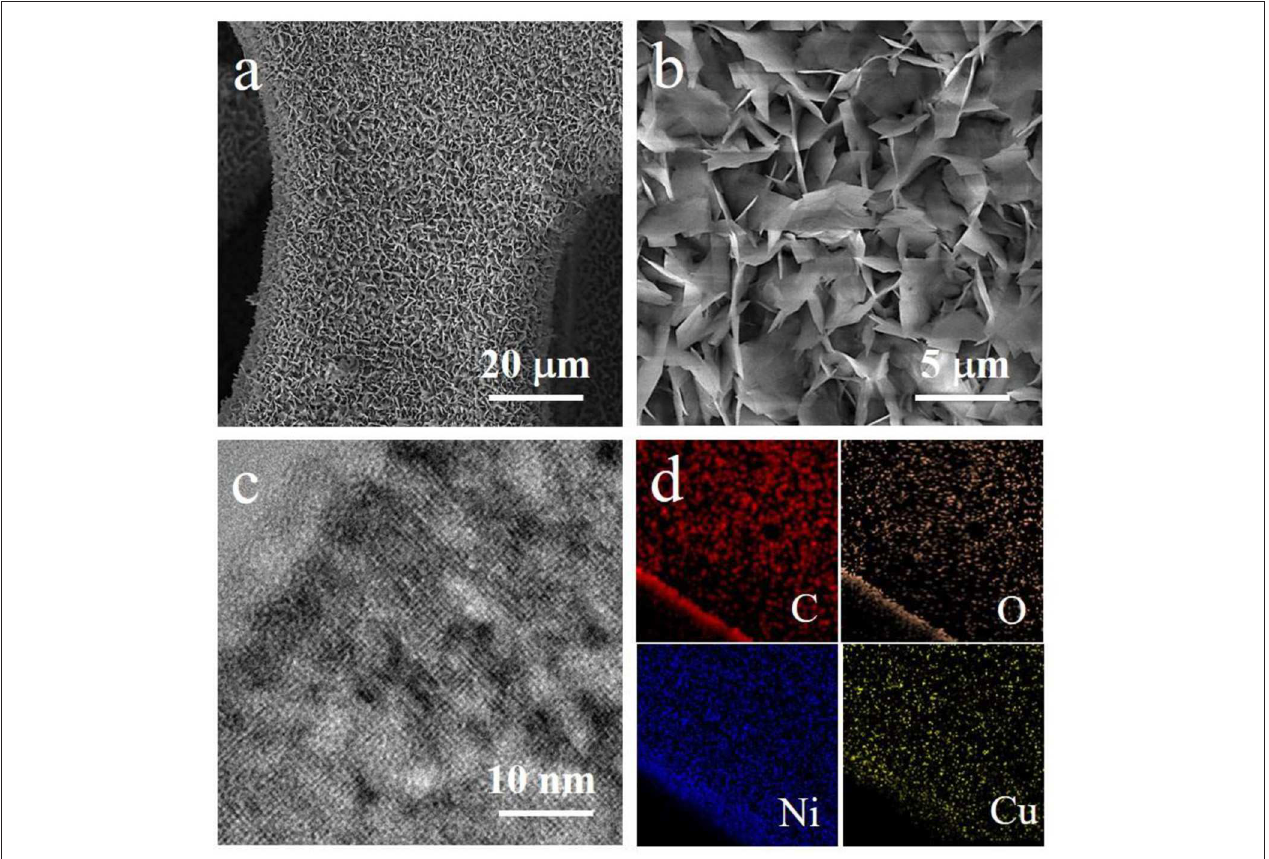
FIGURE 2 | SEM images of (a,b) Ni,Cu-MOF coated nickel foam. (c) TEM image of the porous Ni,Cu-MOF nanosheet. (d) EDS elemental mapping scanning from TEM for the corresponding nanpsheet.